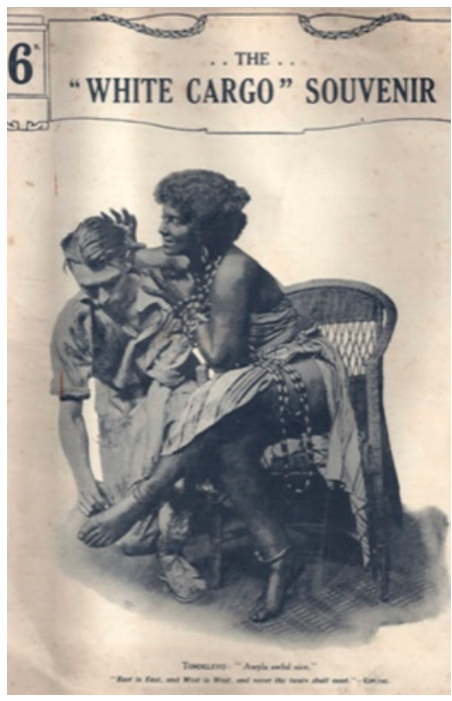
Figure 5. White Cargo by Leon Gordon 1923.